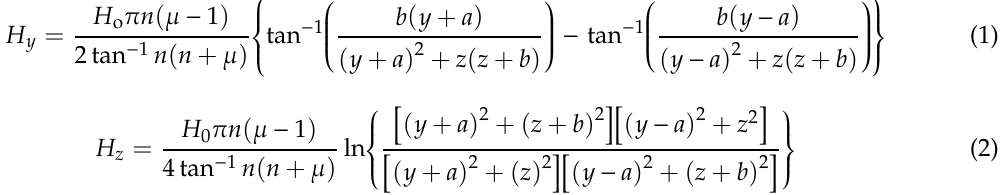
Figure 2. Variation of the normal ( Hy ) and tangential ( Hz ) metal magnetic memory (MMM) signals for a rectangular defect of a ferromagnetic sample with magnetic charge density ± S m .